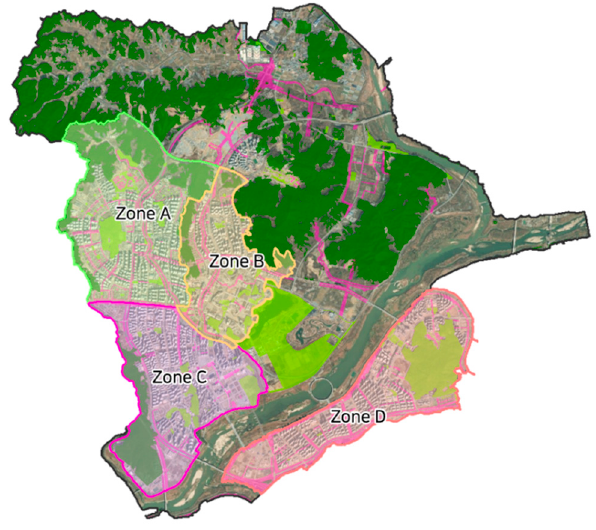
Figure 13. Division of zones for wind corridor forest implantation in HBC region based on administrative districts.